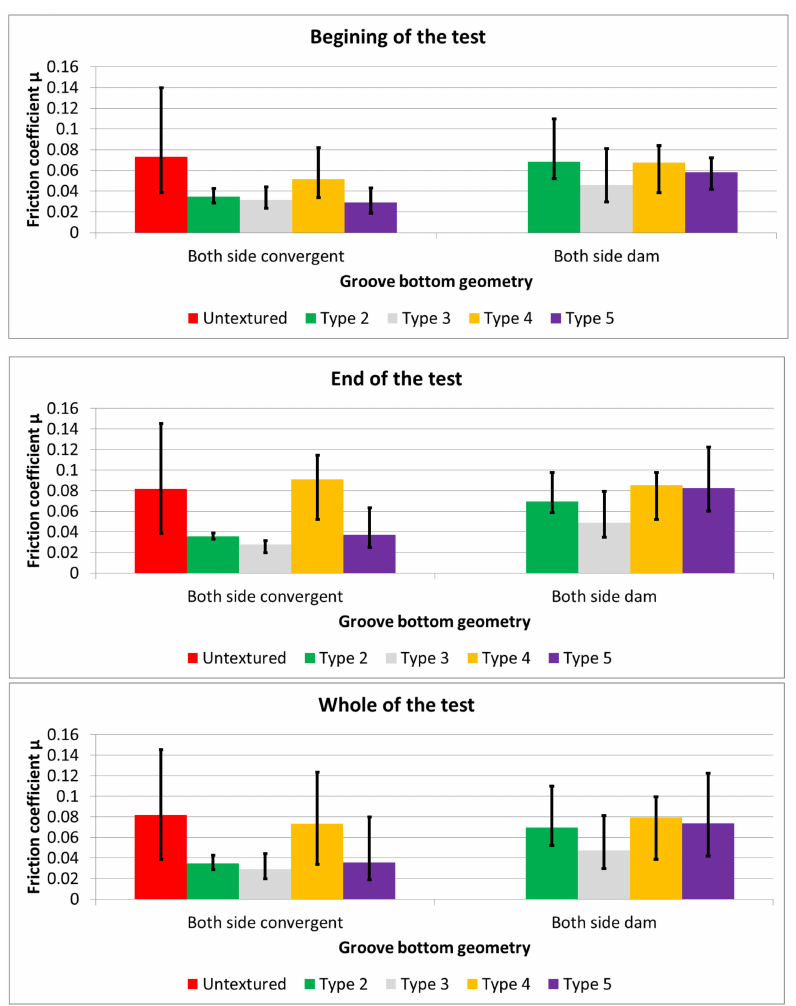
Figure 12. Average friction coe ffi cients with scatters for assemblies with textured discs with spiral grooves (of types 2, 3, 4, and